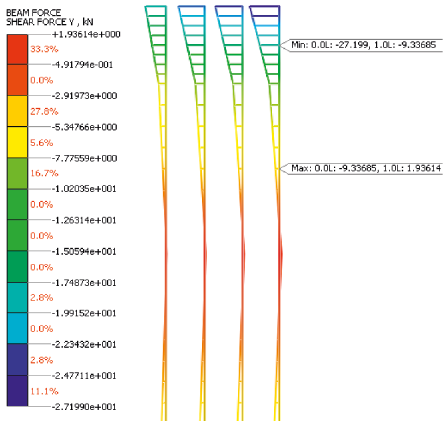
Figure 15: Cloud diagram of shear force distribution of typical pile